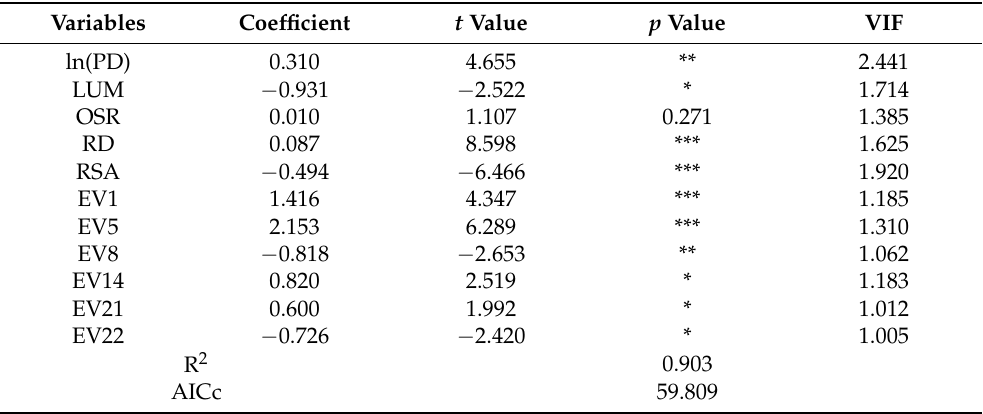
Table 13. Regression results of ESF model II (ln(Comp_V) as the dependent variable). Variables Coefficient